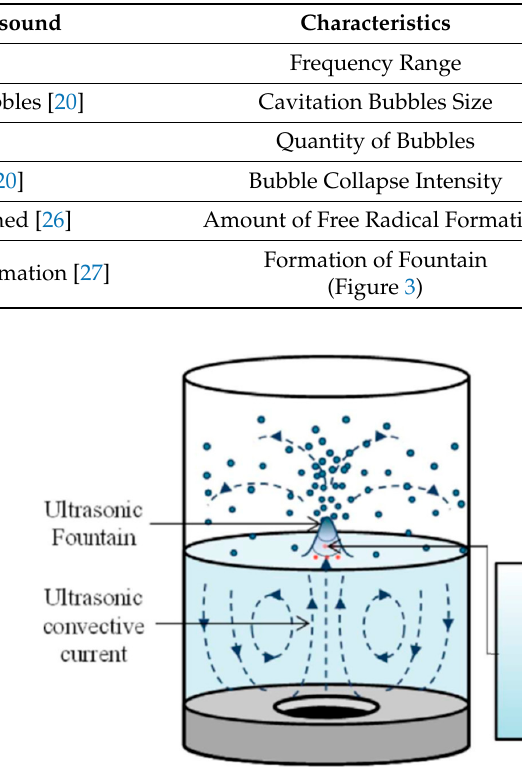
Table 1. Comparison between high- and low-frequency ultrasound.